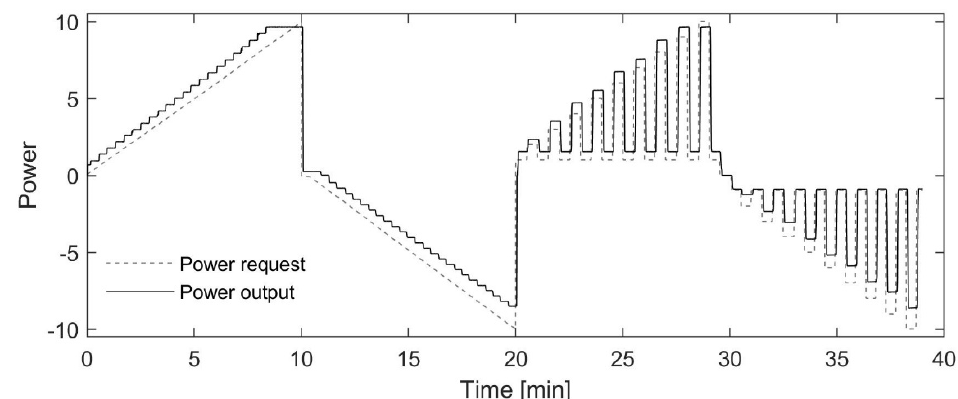
Figure 3. Power requests (in dashed grey) and effective AC active power flow (in black) during the implementation of the proposed procedure. Throughout the section, this data is used to calculate various characterization metrics for the tested V2G commercial charger.